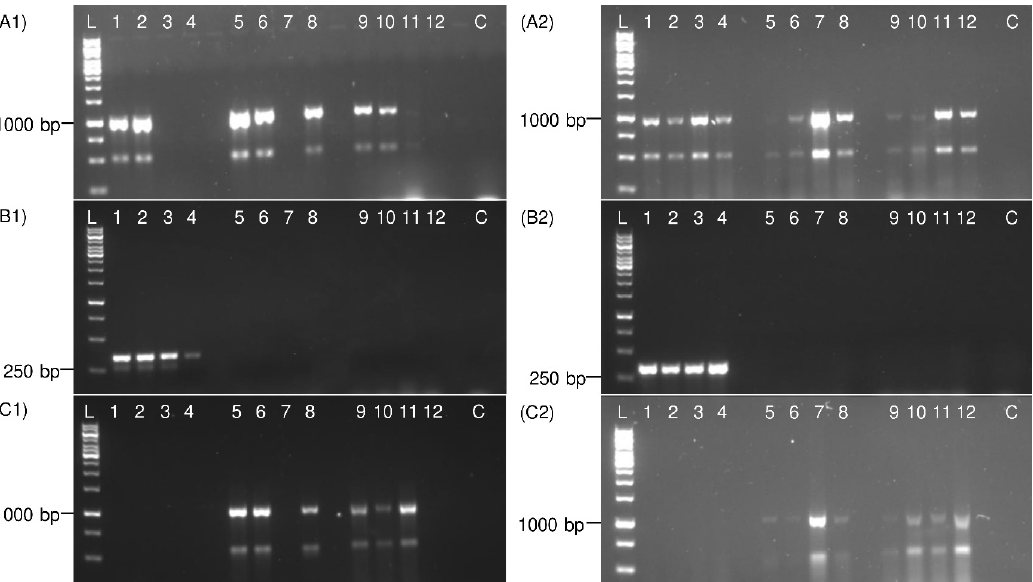
Figure 5. Electrophoretic patterns of PCR products show specific P. leporinus detection from PBS extracts. Adult specimens were collected from either sweep nets ( A1 , B1 , C1 ) or sticky traps ( A2 , B2 , C2 ). In panels ( A1 , A2 ), universal Ron and Calvin primers, in panels ( B1 , B2 ), specific P. leporinus primers and in panels ( C1 , C2 ), universal UEA3 and UEA8 primers were used for PCR assay. Lanes 1, 2 represent P. leporinus male adult samples; 3, 4 P. leporinus female adult; 5, 6 R. quinquecostatus male adult; 7, 8 R. quinquecostatus female adult; 9, 10 H. obsoletus male adult; 11, 12 H. obsoletus female adult; C: Negative control (water). The sizes of amplicons are shown on the left side and compared with 1 kb ladder (L).